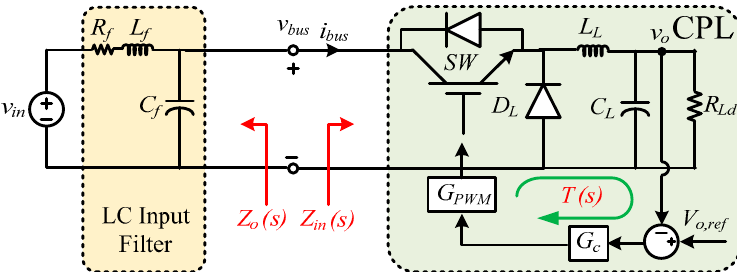
Figure 14. Cascaded system given in [93].